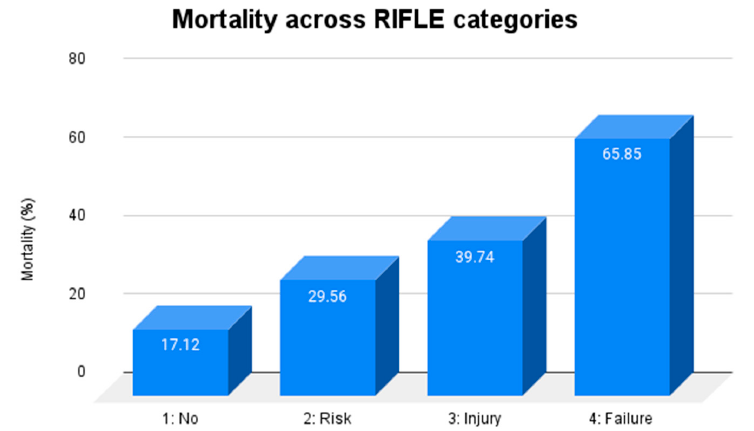
Figure 1. Mortality rate according to the development of AKI in TBI patients. RIFLE: Risk, Injury, Failure, Loss of kidney function and End-stage kidney disease. Table 3. The results of the logistic regression analysis aiming to identify risk factors associated with AKI. with age and the initial hemodynamic response (Figure 2).